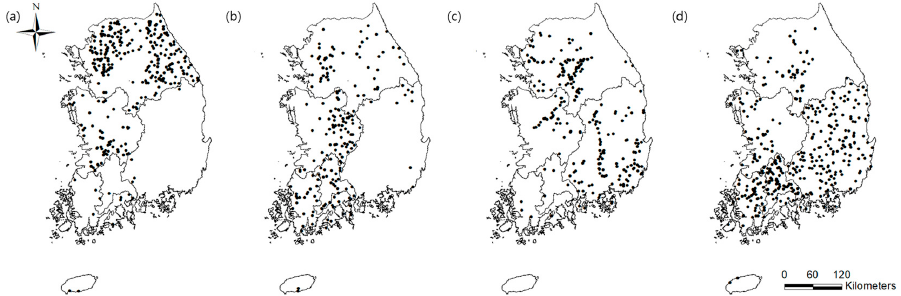
Figure 3. Distribution of sampling sites in each group defined from hierarchical cluster analysis. ( a ) group 1, ( b ) group 2, ( c ) group 3, and ( d ) group 4.